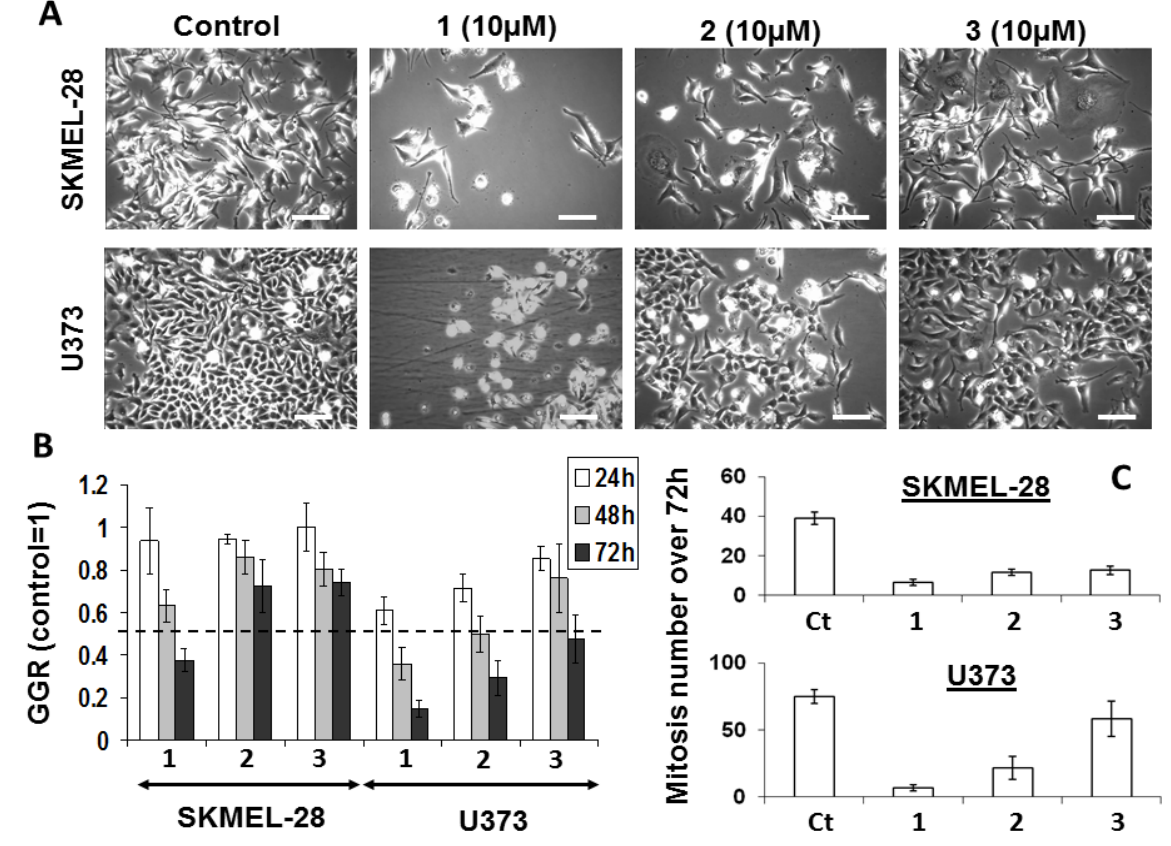
Figure 2. ( A ) Images of SKMLEL-28 and U373 cells left untreated or treated with 10 µM of bastadins at 10 µM during 72 h. Scale bar: 100 µm. ( B ) Global Growth Ratio for each experiment at 24 (open bars), 48 (gray bars) and 72 h (black bars) of treatment. ( C ) Number of mitoses that occurred over the 72 h period of observation for each experimental condition (control versus bastadin treated cells at 10 µM). Data are expressed as the means ±